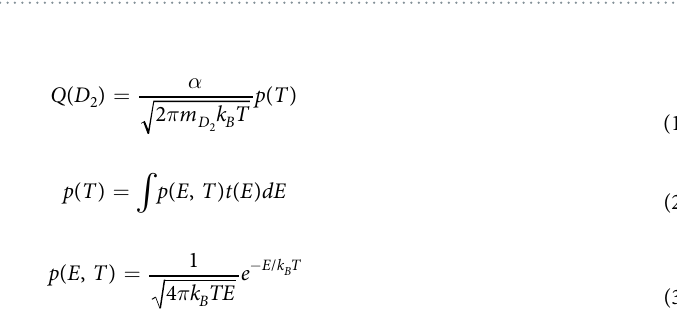
Table 1. The separation abilities of C 2 N- h 2D membrane for hydrogen isotopologues (H 2 , HD, HT, D 2 , DT, T 2 ). The tick symbol indicates that the C 2 N- h 2D membrane is able to efficiently separate two isotopologues with industrial acceptable permeance and selectivity, while the cross symbol represents the opposite